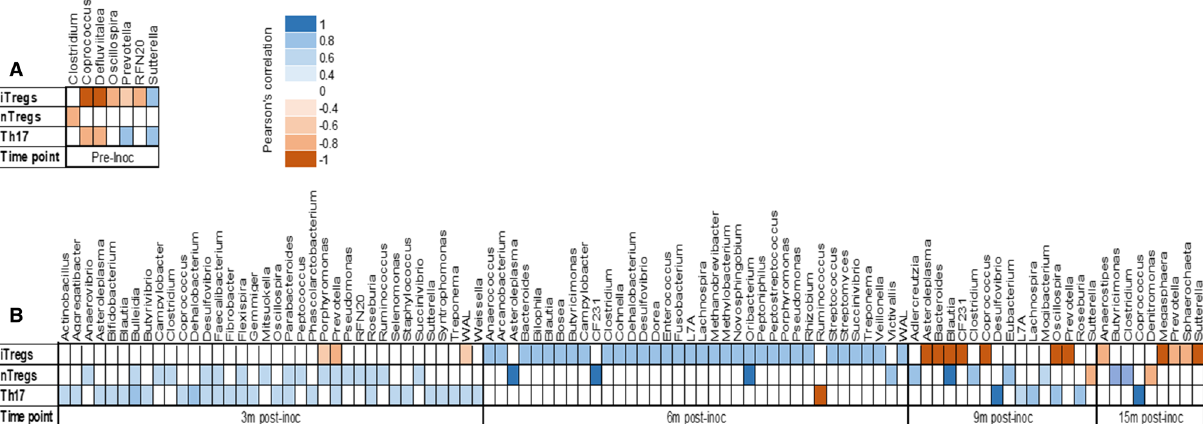
Figure 7. Pearson’s correlation coefficient of GI bacterial communities with level of peripheral immune cell populations (iTregs, nTregs, Th17) in 8 non-human primates from pre- and post-inoculation of endometriosis. ( A ) Pre-inoculation. ( B ) Post-inoculation.